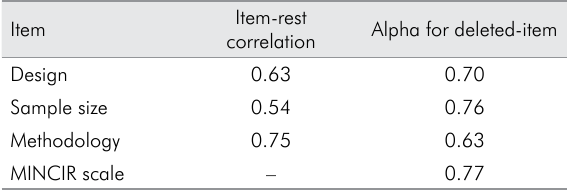
Table 3. Internal consistency of the MINCIR scale.